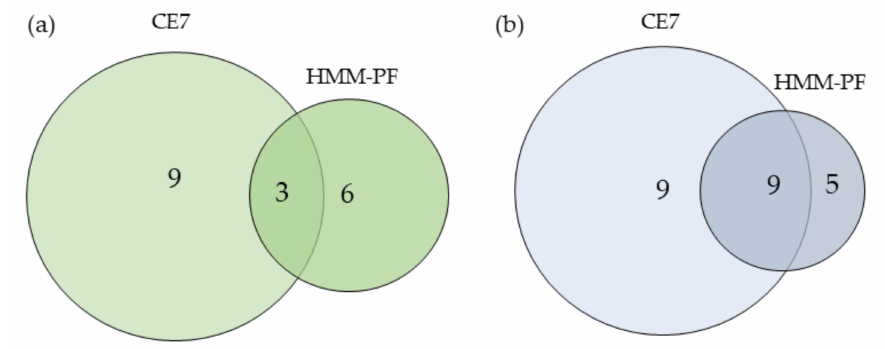
Figure 6. Comparative proteins lacked signal peptide ( a ) and with signal peptide ( b ) in the Penicillium rubens strain 212 crude extract after growth for seven days in Morton’s medium (CE7) and the high molecular mass protein fraction (HMM-PF) identified in predictive genome of PO212 by nLC-MS / MS. The identified proteins were distributed according to their corresponding function (according to UniProt). SignalP, Signal Peptide was predicted based on SignalP